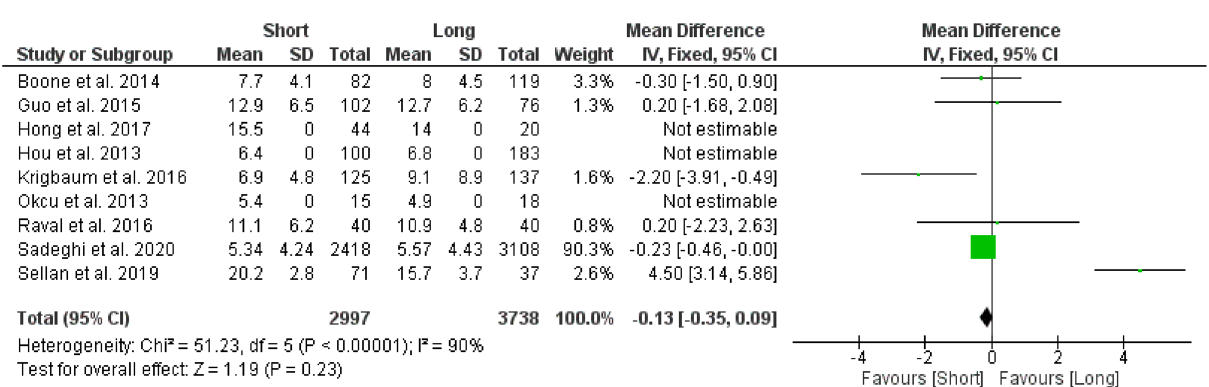
Figure 4. Forest plot of mean estimated blood loss between long and short CMD groups. Green boxes represent weighted mean values of each study. The black diamond represents the overall pooled weighted mean of all included studies.